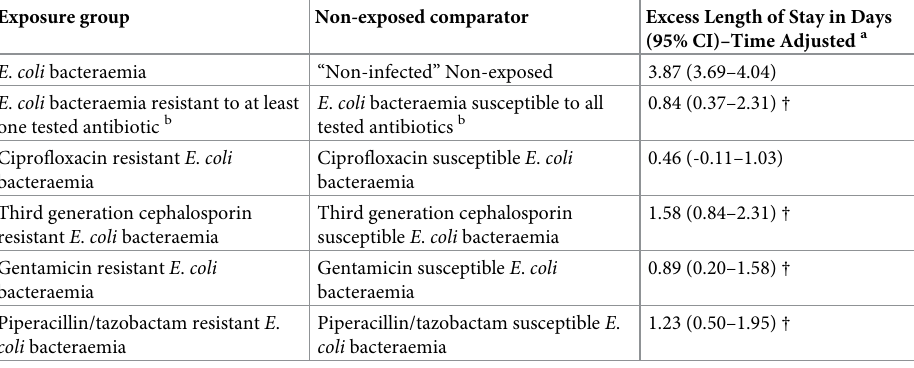
Table 4. Excess length of stay estimated by multistate models.